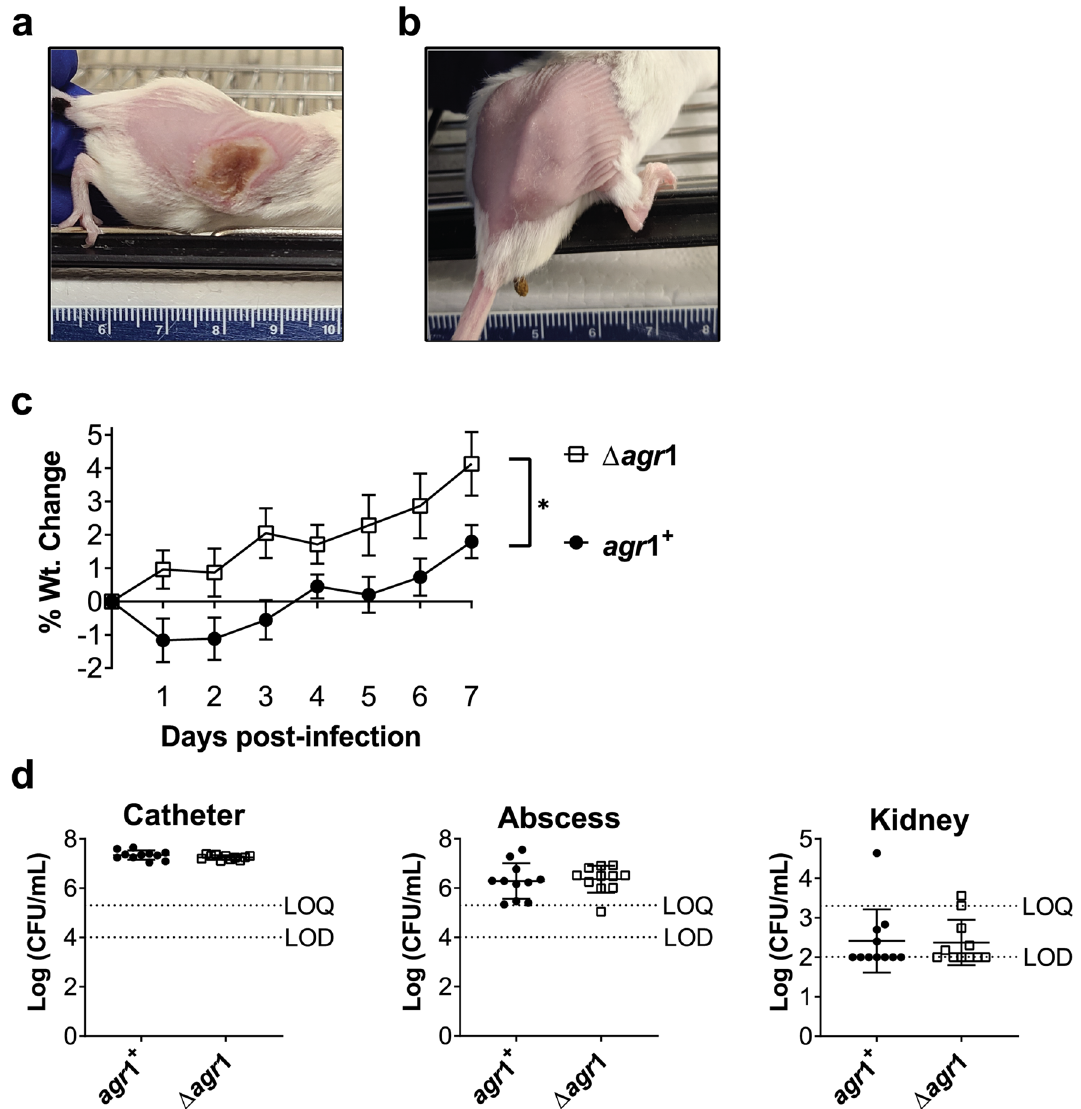
Figure 5. agr 1 + is more pathogenic than Δ agr 1 in a mouse model of implant associated infection. Gross pathology on day 3 post-infection of a subcutaneous ( a ) compared to an implant-associated ( b ) infection with agr1 + S. aureus in a BALB/c mouse. ( c ) Percent weight change of mice over 7 day infection. ( d ) Bacterial burden (CFUs) on implanted catheter (left), surrounding abscess (middle), and in the kidneys (right) on day 7 post- infection. Data are the average of two experiments with a cumulative total of n = 11 mice per group and are expressed as the mean ± SEM ( p -values: * p <